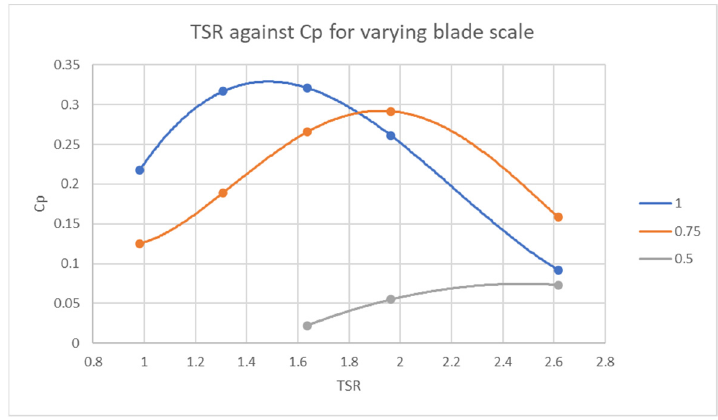
Figure 10. Performance curve for varying blade scales.